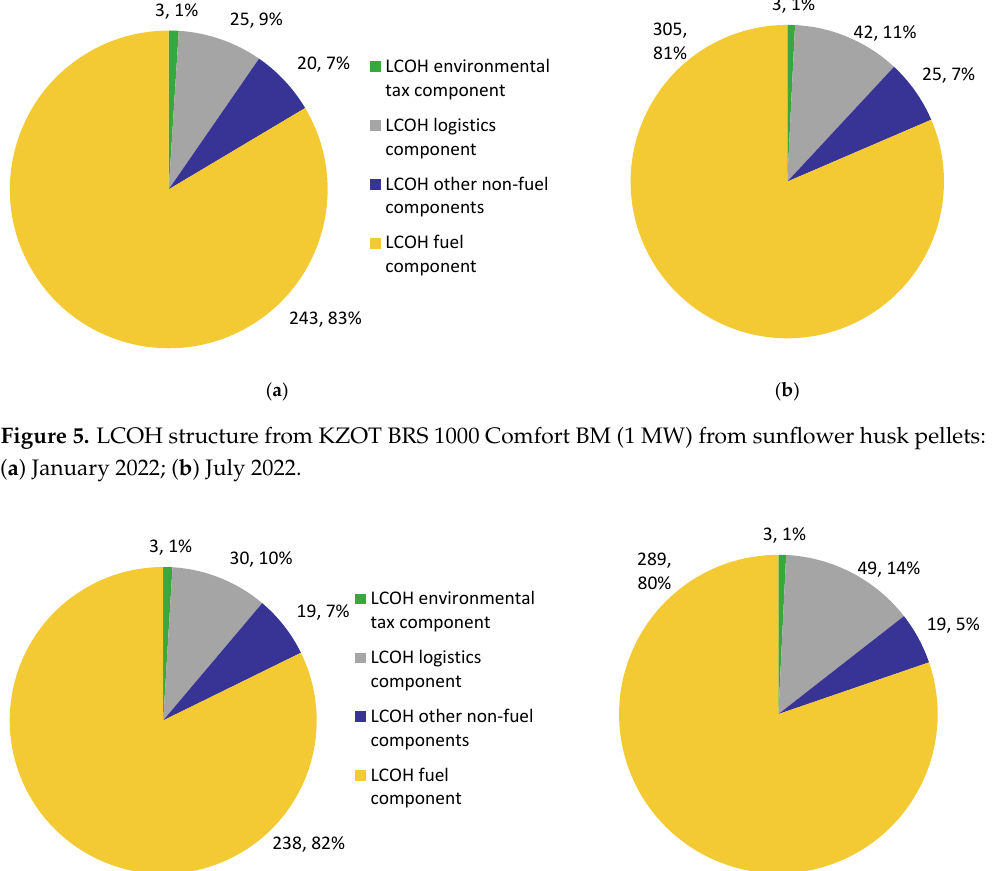
Figure 4. LCOH structure from KZOT BRS 1000 Comfort BM (1 MW) from wood pellets: ( a ) January 2022; ( b ) July 2022.